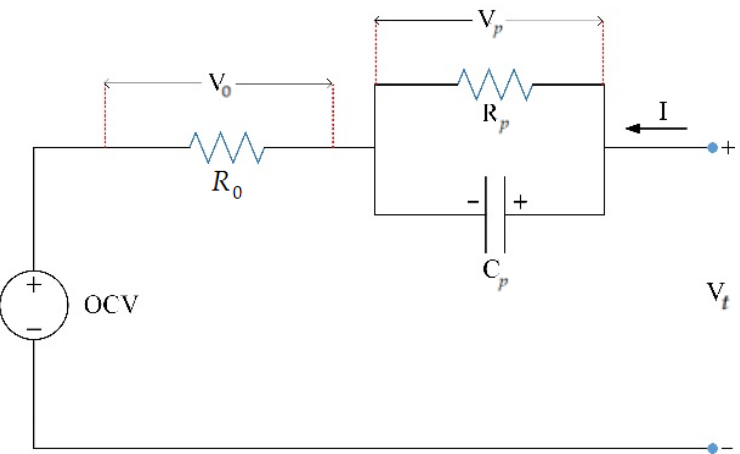
Figure 1. First ‐ order equivalent circuit model of Li ‐ ion battery.